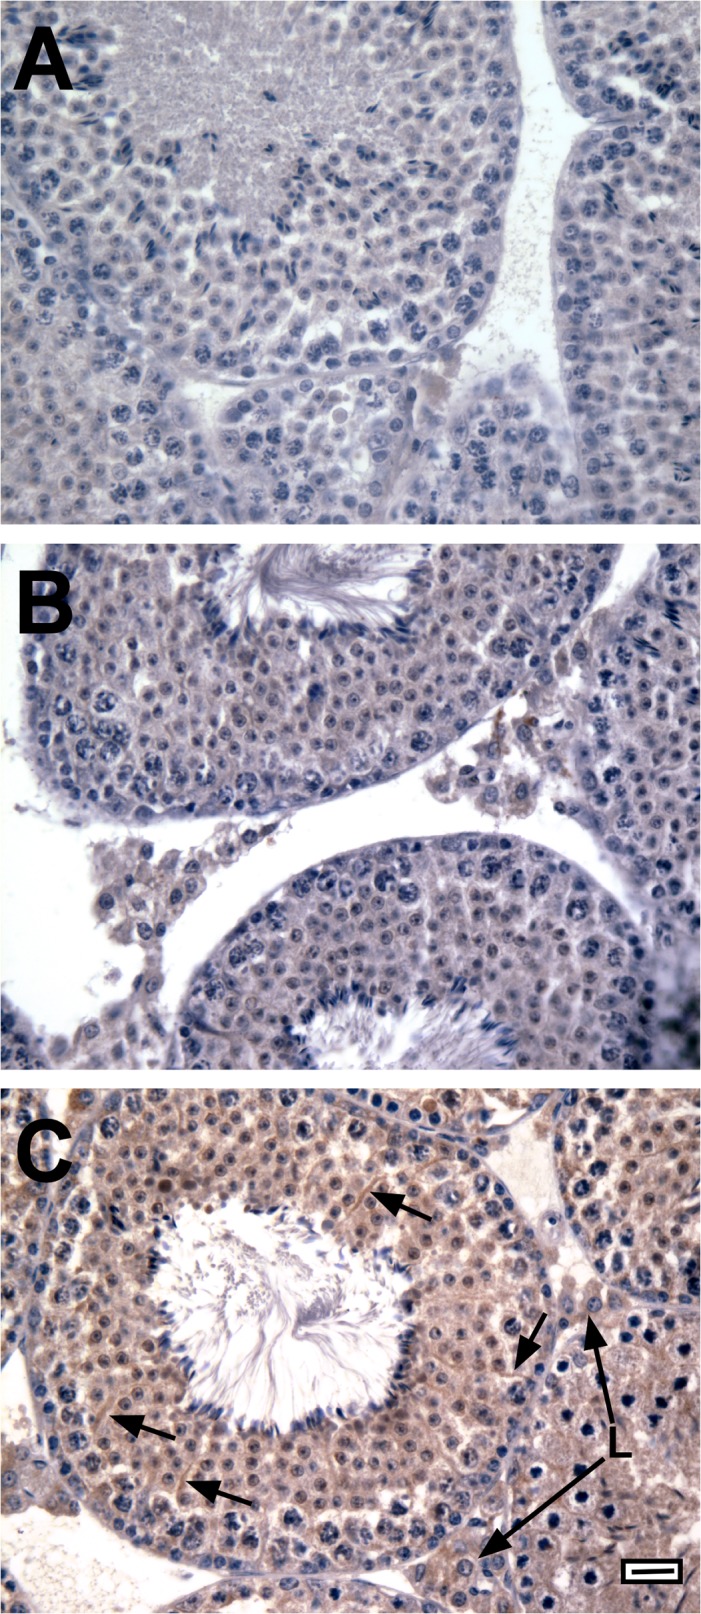
EGFP is expressed in the testes of mice containing the AR-EGFP transgene.Testis tissue sections from mice containing the AR-GFP transgene (A, C) and a mouse lacking the transgene (B) were probed with secondary antisera alone (A) or with antiserum against GFP and secondary antisera (B, C). Strong EGFP immunoreactivity (brown stain) was observed only in testes containing the AR-GFP transgene probed with EGFP antiserum (C). EGFP immunoreactivity was present in the cytoplasm of Sertoli cells including concentrations of EGFP in the Sertoli cell cytoplasm surrounding germ cells (arrows) and in the cytoplasm of Leydig cells (L, long arrows). Nuclei are stained blue with hematoxylin. Bar = 100 μm, magnification: 40x objective.